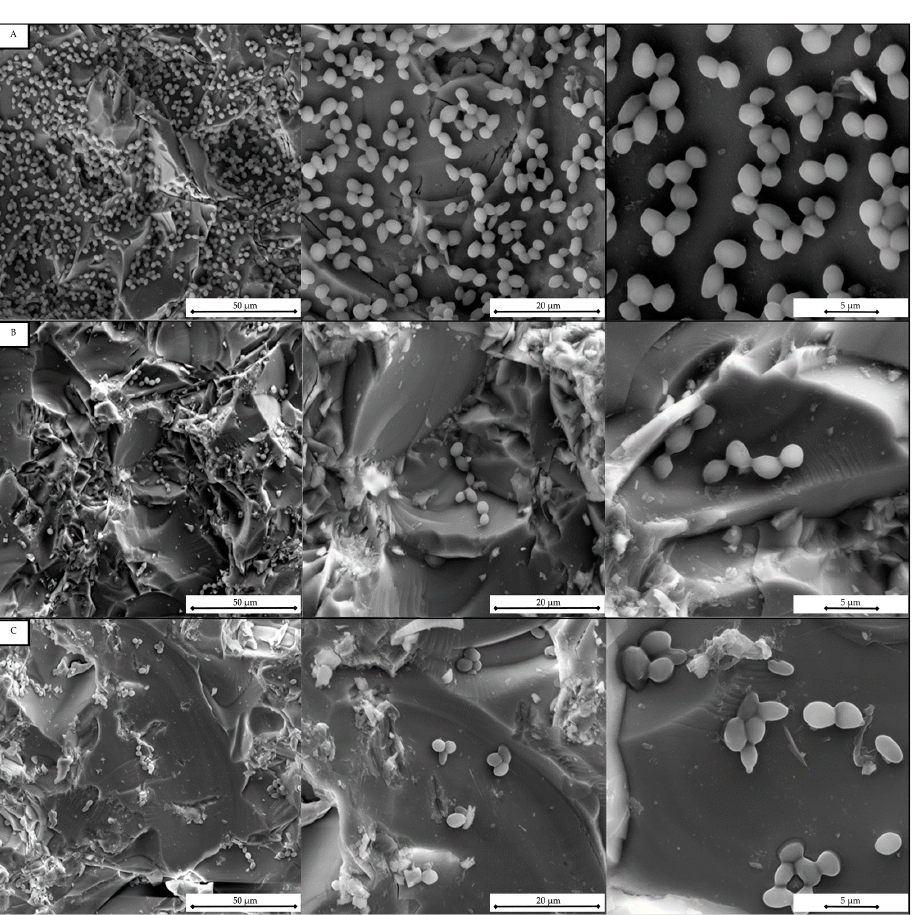
Figure 3. SEM images of C. auris bio fi lm ( A ). untreated (Control) ( B ). Treated with 53 µg/mL of LOT-I: and ( C ). Treated with 141 µg/mL of EO LOT-II. SEM images were recorded at 2000 and 5000, and 10,000× magni fi cation, respectively.